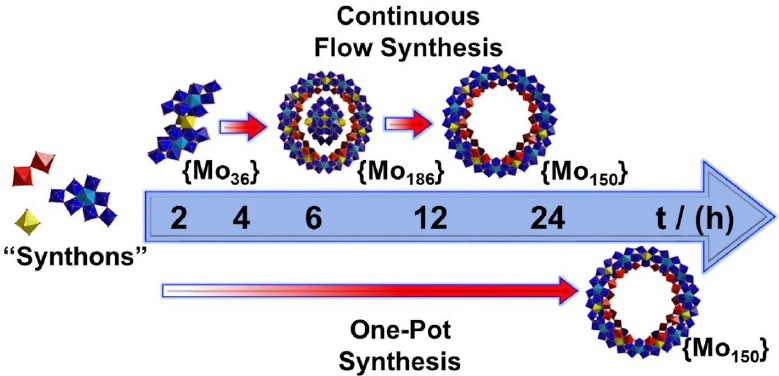
Figure 3. Formation of {Mo 186 }, {Mo 150 } and {Mo 36 } complexes. The flow-reaction conditions and the reducing environment are necessary factors for the isolation of {Mo 36 }. Colour scheme, yellow: {Mo 1 }, red; {Mo 2 }, blue; {Mo 8 }.